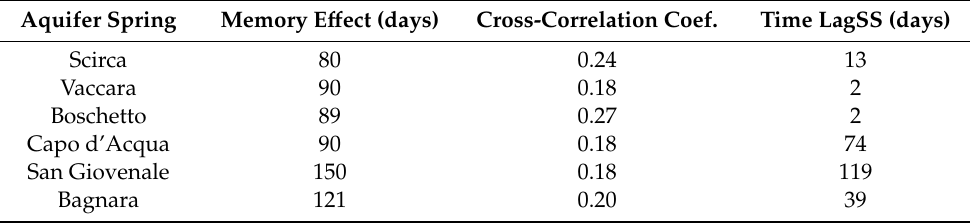
Table 6. Time series analysis parameters: system memory e ff ect, maximum discharge / rainfall cross-correlation coe ffi cient, and time lag for maximum cross-correlation coe ffi cient (Q